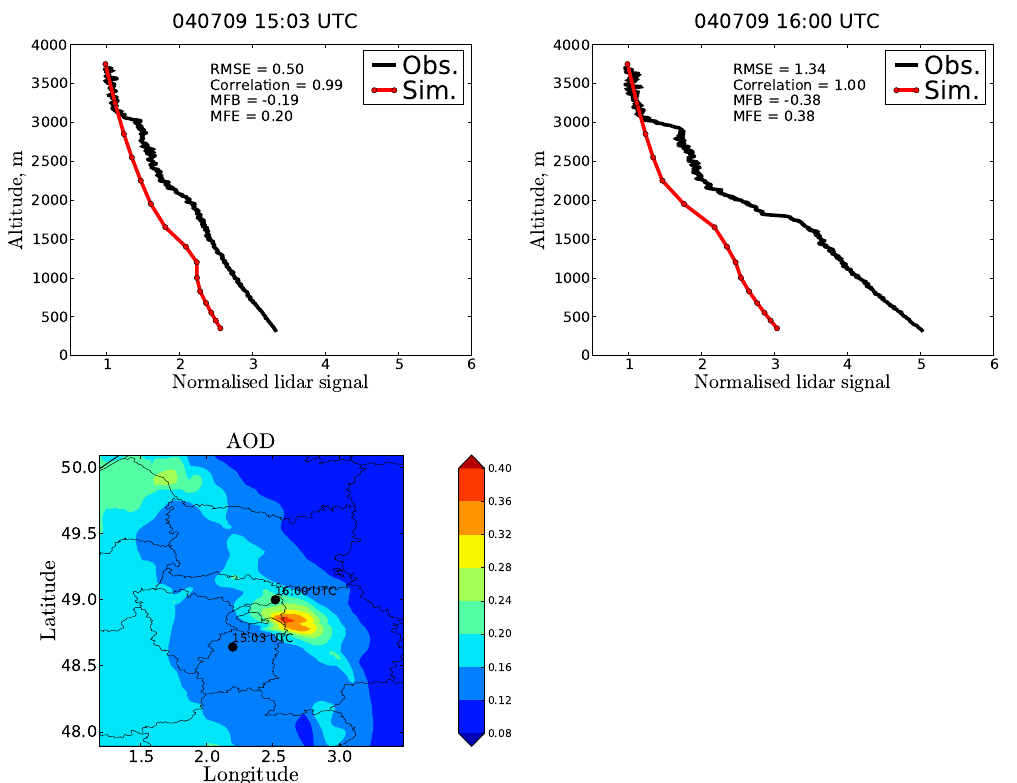
Fig. 5. Comparisons between the vertical profiles observed by GBML (black lines) and simulated by P OLYPHEMUS (red lines) on 4 July 2009 at 15:03 and 16:00UTC. Lidar observations below the altitude of full overlap are not represented. The lower-left panel shows the positions of the different lidar profiles and the horizontal distribution of the mean of the AODs at 15:00 and